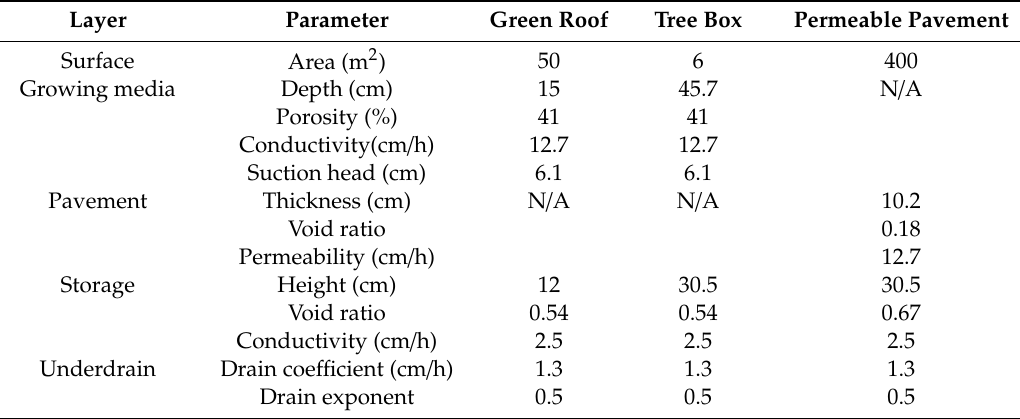
Table 2. Parameters of low impact developments (LIDs) for